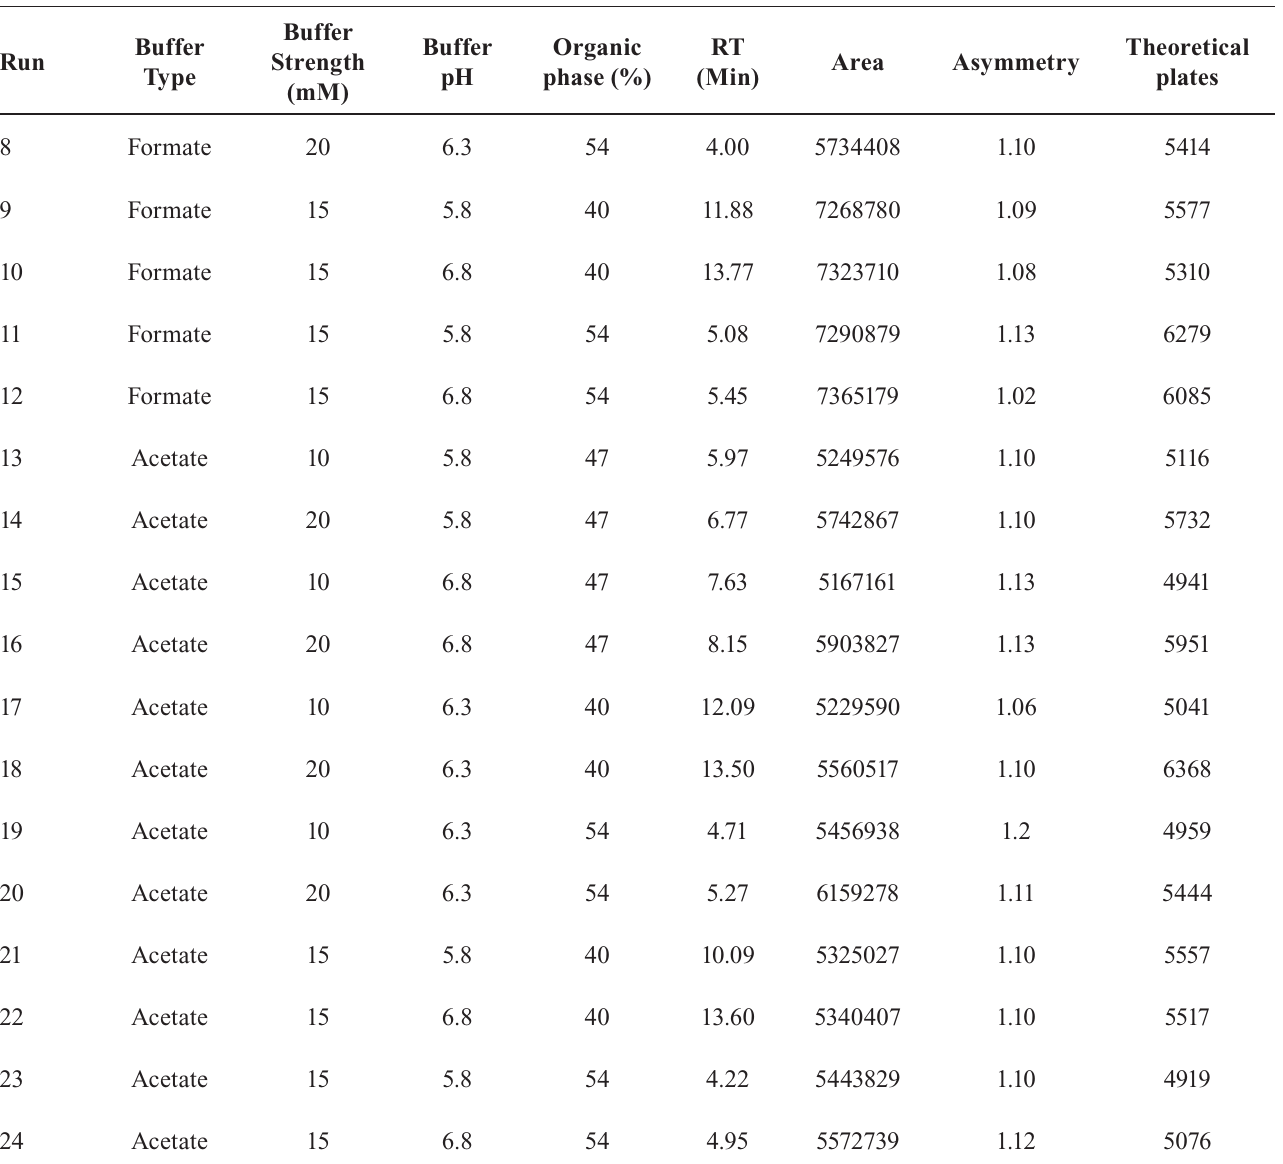
TABLE I - Experimental data for optimization of the